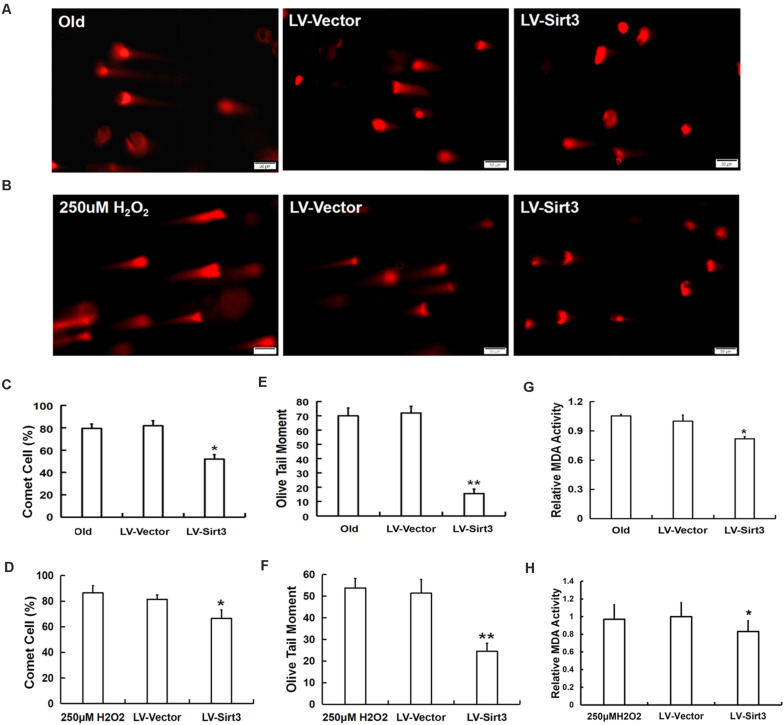
Sirt3 alleviated MSC senescence through ameliorating DNA damage and intracellular MDA contents. DNA damage was determined by comet assay in both natural and premature senescent cells upon Sirt3 replenishment (A,B). Fluorescent images and the quantitative analysis of comet-positive cells (C,D) and olive tail moments (OTM) (E,F). (G,H) The levels of intracellular MDA were determined by colorimetry in the old group (G) and H2O2-treated group (H). Data are expressed as mean ± SD, n = 3. *P < 0.05, **P < 0.01 vs. old or H2O2.